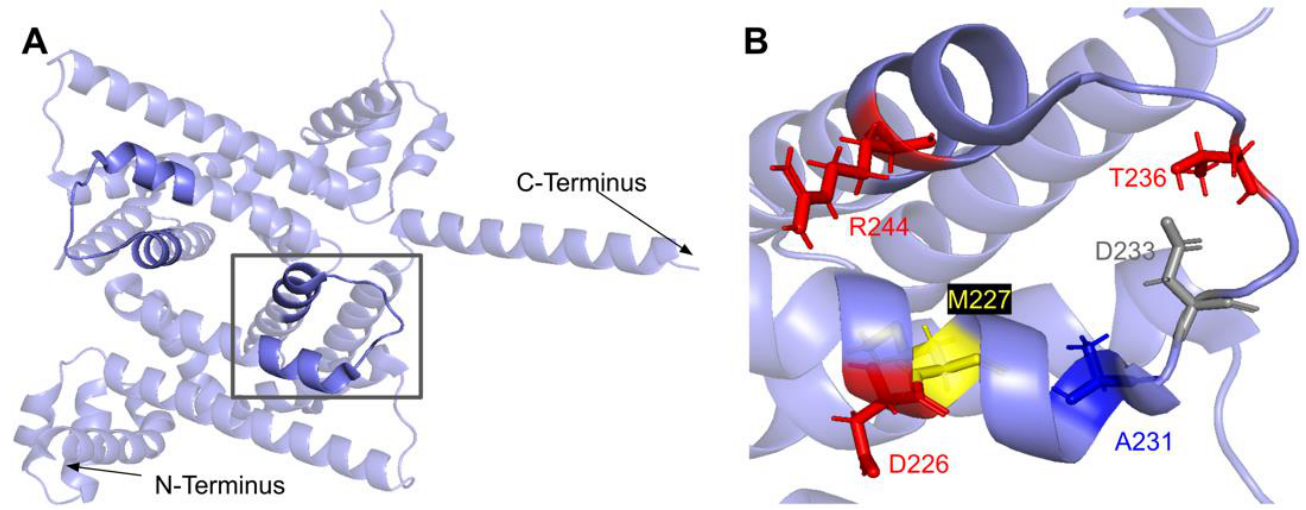
Figure 31. SNVs found in the COQ9 surface patch. ( A ) Surface patch highlighted on the COQ9 dimer (PDB:6AWL), corresponding to residues D225 to L247. ( B ) Locations of SNVs are depicted. Residues are colored according to their corresponding SNVs in Figure 28.